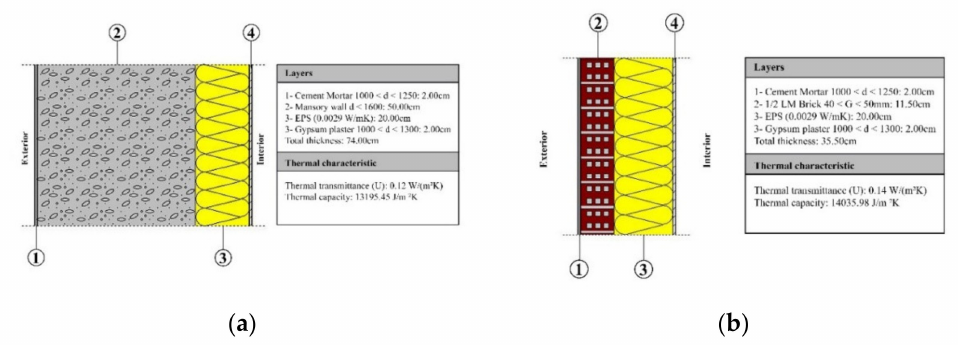
Figure 5. ( a ) Construction improvements: incorporation of thermal insulation on masonry walls installed on the ground floor; ( b ) construction improvements: incorporation of thermal insulation on a simple brickwork layer installed on the first and second